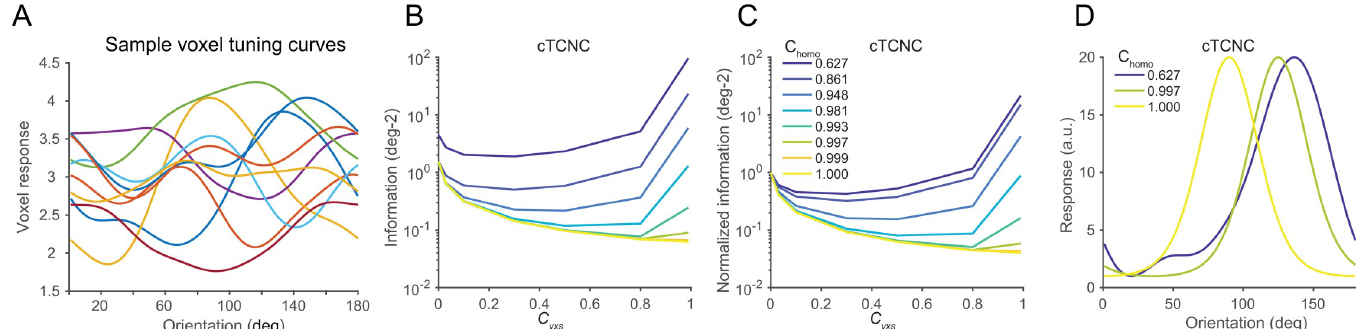
Fig 8. Interaction between cTCNC and tuning heterogeneity on population codes. 500 voxels were simulated (see Materials and Methods). A larger value of c homo indicates more homogeneous voxel tuning curves. Note that the simulated voxel tuning curves are identical to neuronal tuning curves when c homo = 1. Panel A illustrates some sample tuning curves of the simulated voxels. Due to the uncertain neuron-to-voxel connections (i.e., linear weighting matrix W ), the endowed voxel tuning curves also exhibit irregular forms. Panels B and C illustrate the raw and normalized amount of information as a function of cTCNC under different tuning heterogeneity levels. = 0 (panel C). As voxel tuning homogeneity increases, the shape of the functions changes from U-shaped to The raw information is normalized to the condition when c vxs monotonically decreasing. Panel D illustrates sample voxel tuning curves with different heterogeneity levels.